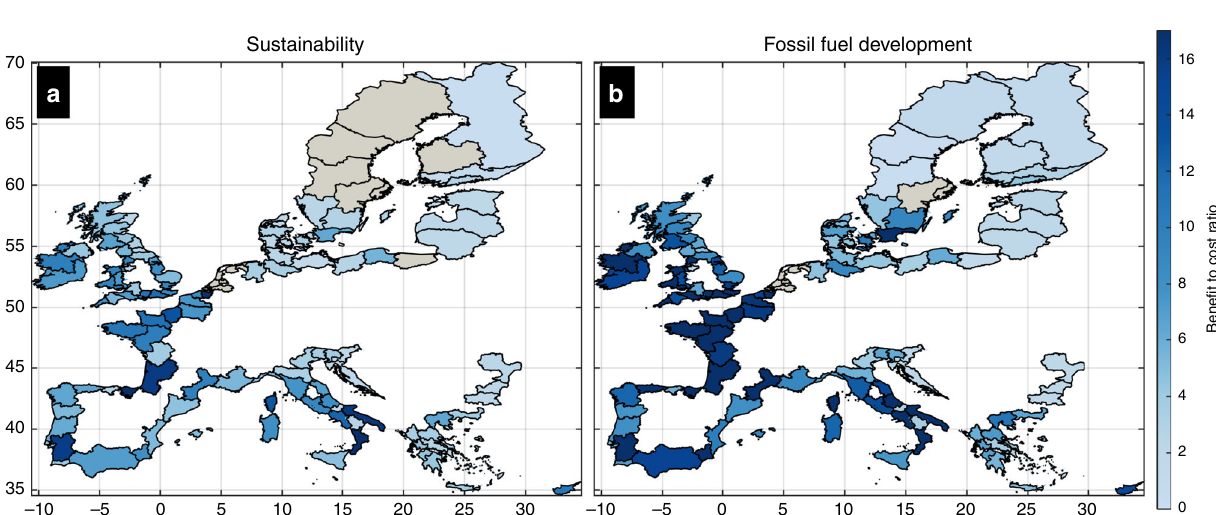
Fig. 1 Bene fi ts vs Costs at regional level. Expected bene fi t to cost ratios of raising coastal protection per NUTS2 region. Values are shown for two scenarios: Sustainability with RCP4.5 ( a ) and fossil fuel based development with RCP8.5 ( b ). Grey colours express areas where the maximum net present value is achieved with the current protection.